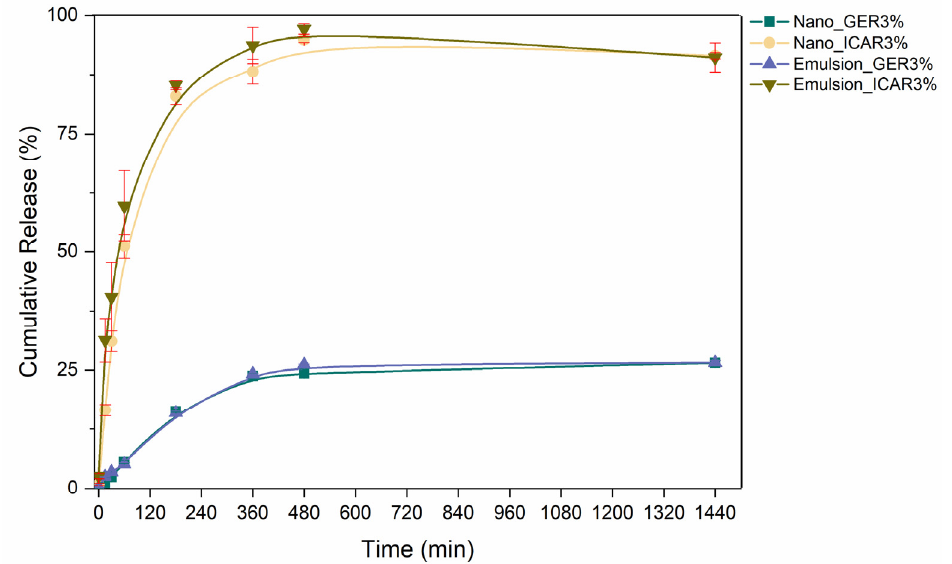
Figure 11. The graph shows cumulative release curves (%) of Nano_GER3% nanocapsules: Nano_ICAR3%, Emulsion_GER3%, and Emulsion_ICAR3% were carried out at a temperature of 32 °C. The analyses were performed in triplicate ( n = 3) and quantification by high-performance liquid chromatography